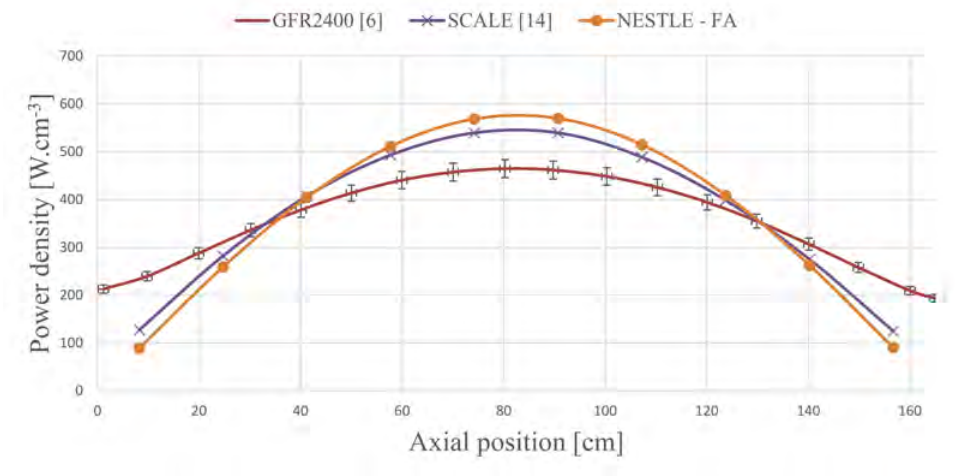
Figure 7. Results of axial power distribution.